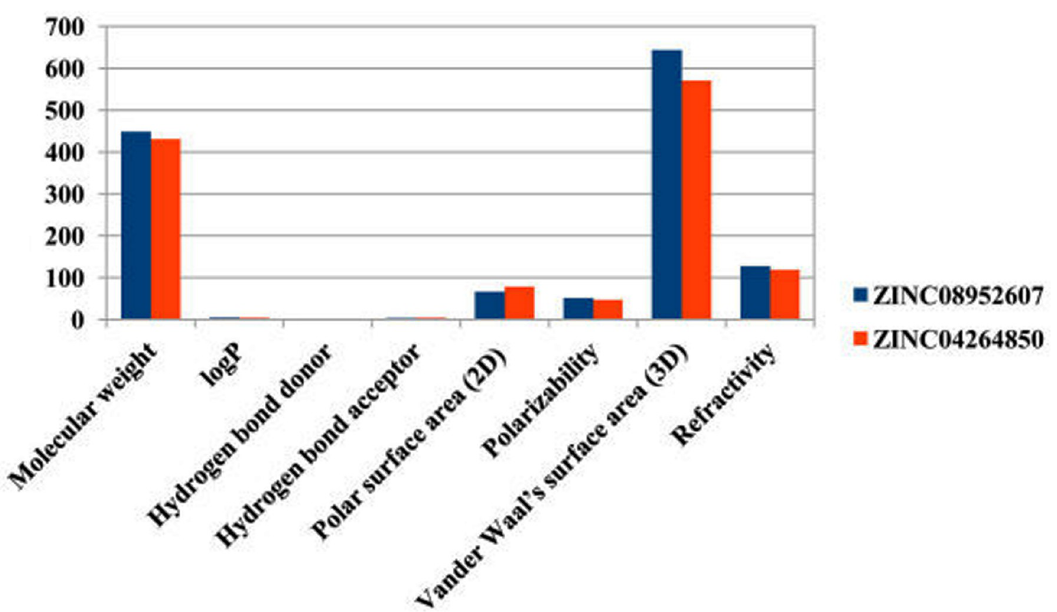
Fig 2. Values of principal descriptors for ZINC08952607 and ZINC04264850.